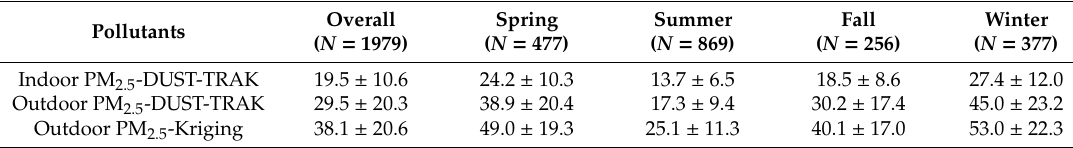
Table 3. Summary of indoor and outdoor PM 2.5 ( µ g / m 3 ) concentrations (mean ±